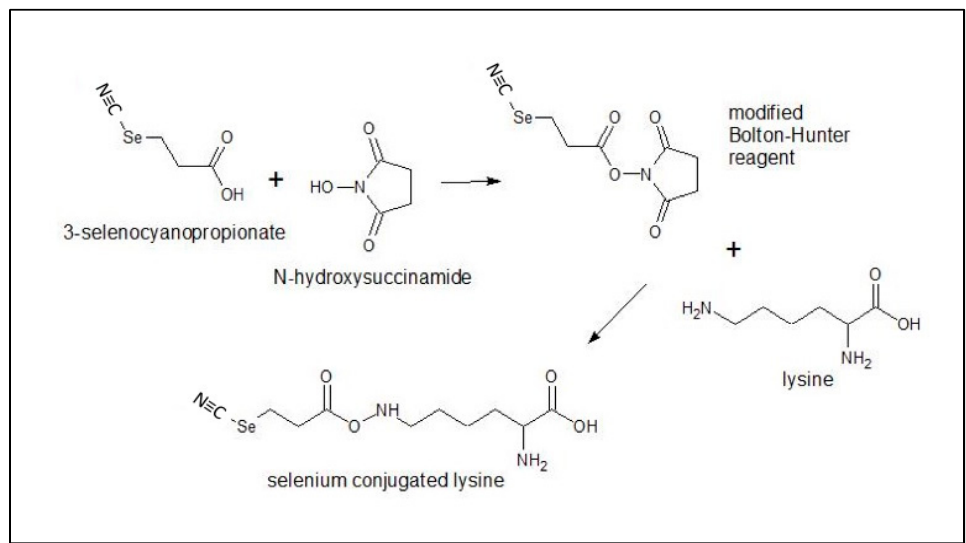
Figure 16. Generation of the modified Bolton-Hunter reagent for conjugation of selenium to lysine..